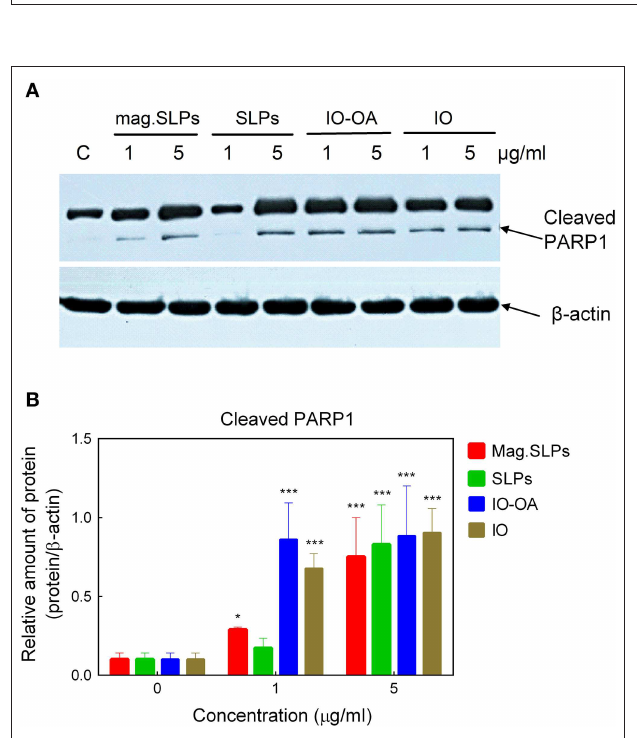
FIGURE 7 | (A) Western blot analysis of the level of cleaved apoptosis-associated PARP1 protein in Jurkat cells treated with mag.SLPs, SLPs, IO-OA, and IO particles (1 and 5 µ g/ml), C - non-treated control cells. (B) Densitometry of protein amount in cells treated with particles (1 and 5 µ g/ml). * p ≤ 0.05 and *** p ≤ 0.001 compared to non-treated control cells.